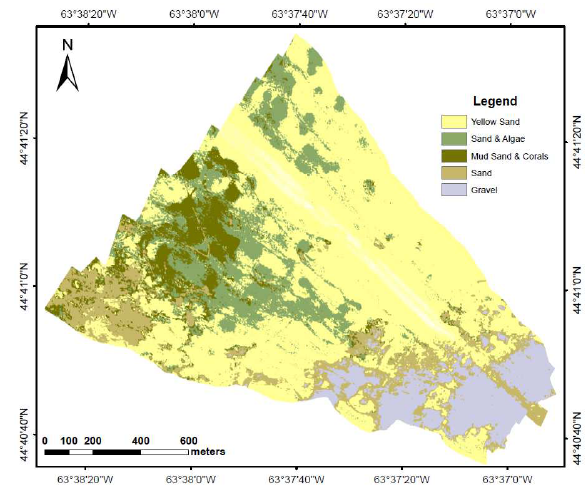
Figure 4: The classification result of Bedford Basin 2016 with five seabed classes. The quantitative evaluation (Table 1) indicated an overall accuracy rate of 99,6%.